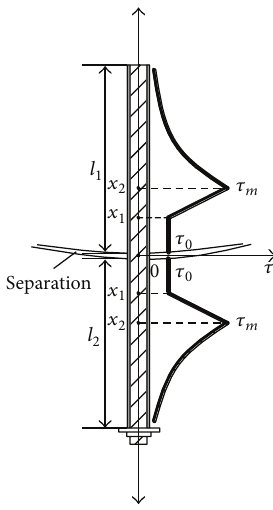
Figure 7: Shear stress distribution of the damaged interface when separation occurs in the middle of the anchoring